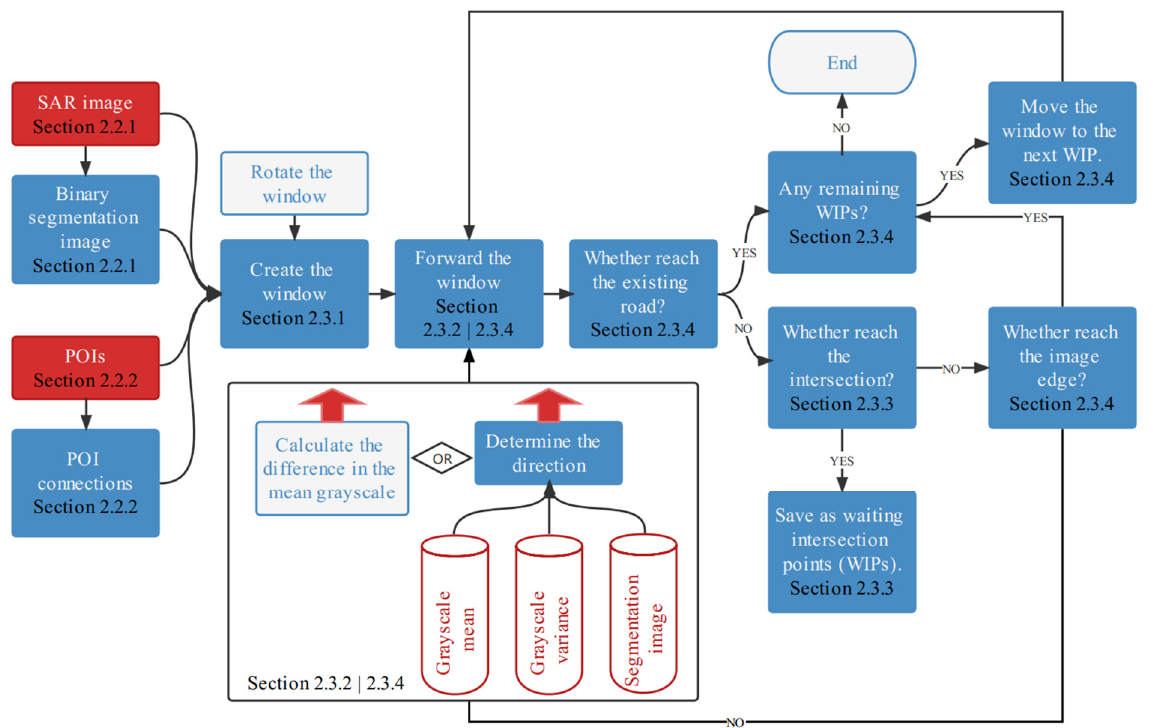
Figure 1. The workflow of the proposed ATP-ROAD method of extracting road networks using SAR images and POIs.